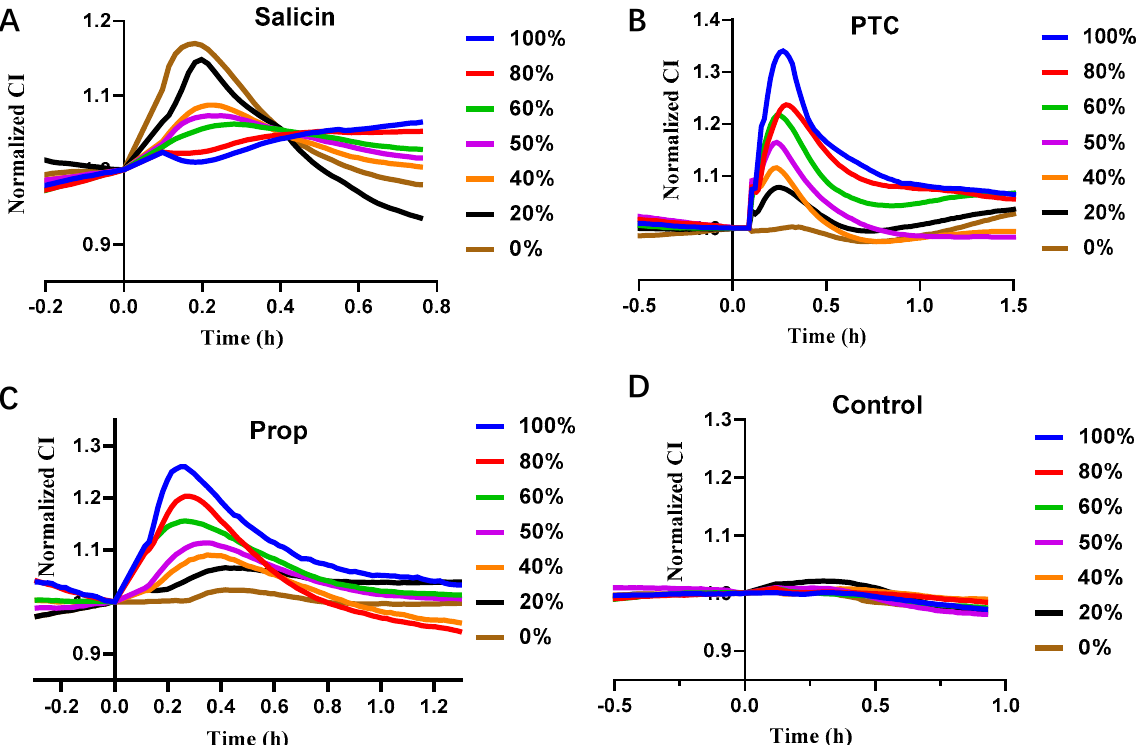
Figure 4. Impedance response curves of cell co − culture taste sensor to ( A ) salicin (400 µ M), ( B ) PTC (100 µ M), ( C ) Prop (100 µ M), and ( D ) PBS (control group). (Max), continuous evolution profiles (CEP), which [Caco-2]/([Caco-2] + [SH-SY5Y]) ratios